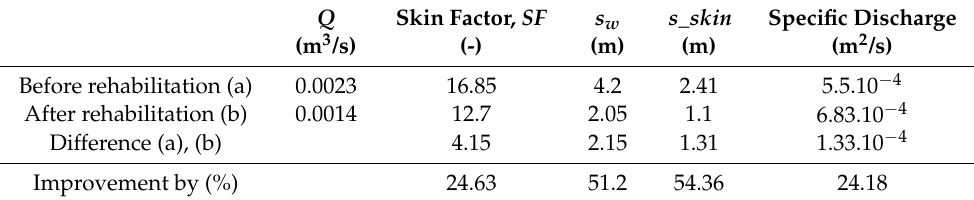
Table 3. Evaluation of the rehabilitation of well MO-4.